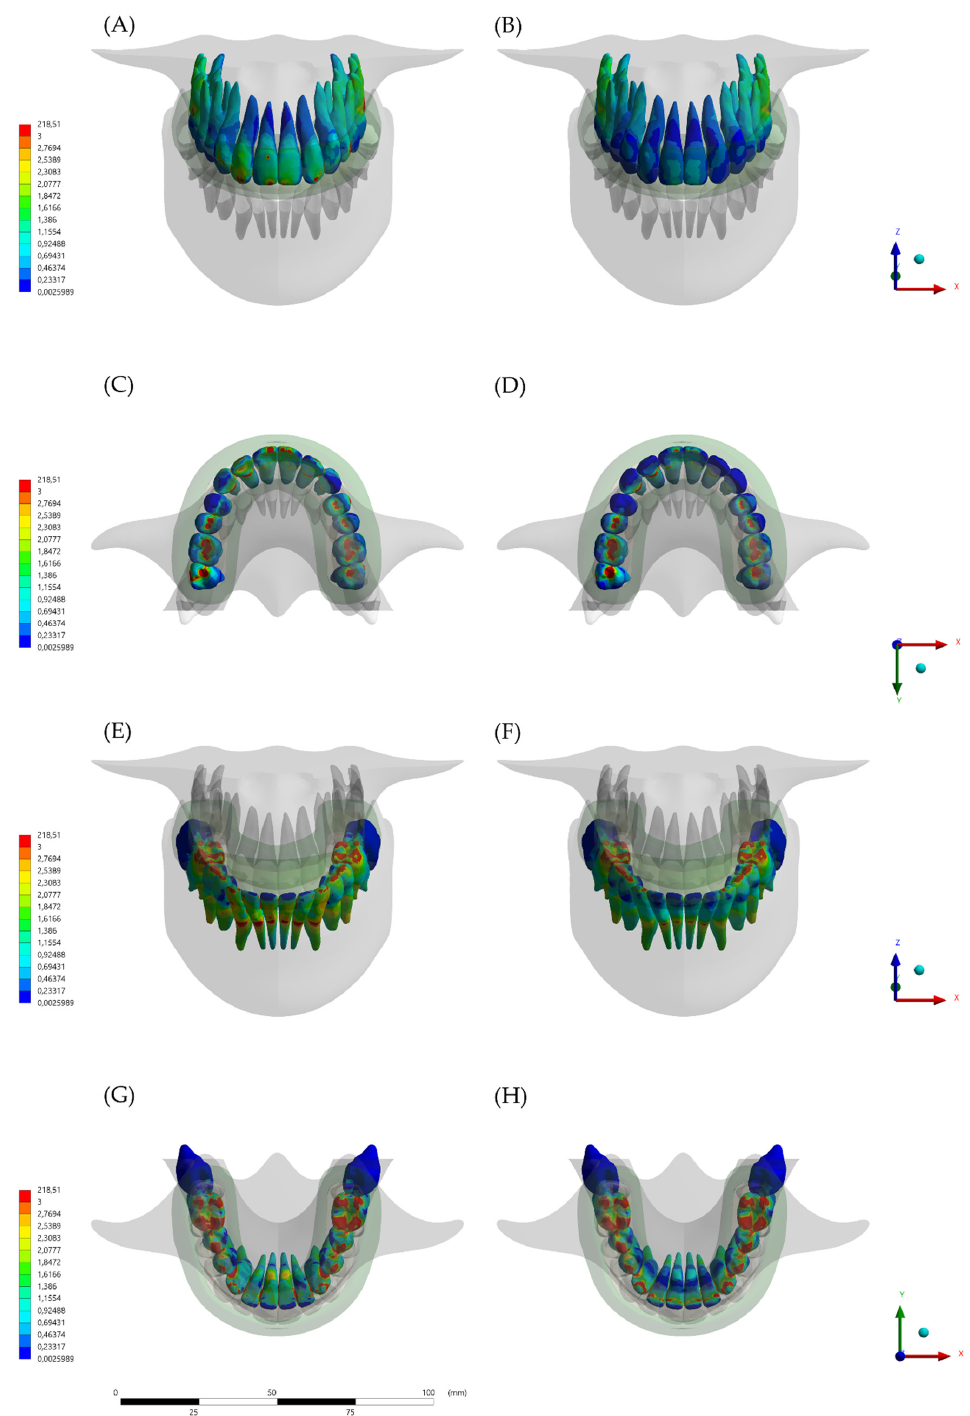
Figure 7. Stress maps in the teeth after the loading according to the different appliance designs and viewports. ( A ) Buccal view of the upper teeth stress with the conventional (MG) design, ( B ) Buccal view of the upper teeth stress with the hybrid (HMG) design, ( C ) Occlusal view of the upper teeth stress with the conventional (MG) design, ( D ) Occlusal view of the upper teeth stress with the hybrid (HMG) design, ( E ) Buccal view of the lower teeth stress with the conventional (MG) design, and ( F ) Buccal view of the lower teeth stress with the hybrid (HMG) design. ( G ) Occlusal view of the lower teeth stress with the conventional (MG) design and ( H ) Occlusal view of the lower teeth stress with the hybrid (HMG)